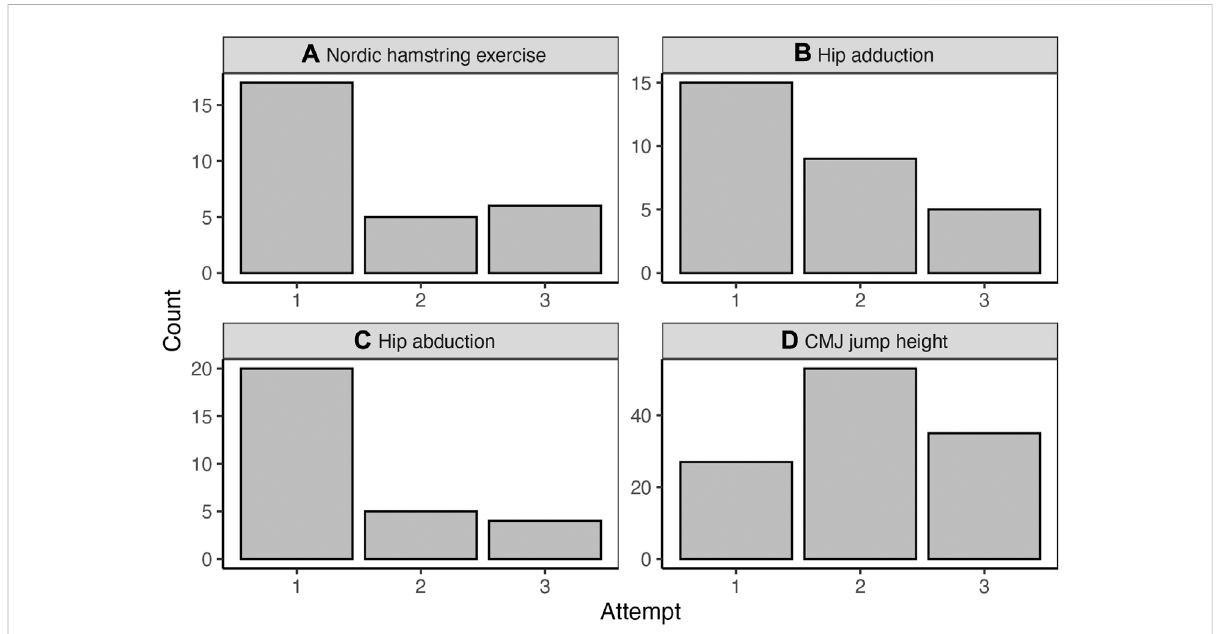
FIGURE 3 Descriptive representation of the best attempt (number of cases on the y -axis) in each test, i.e., Nordic hamstring exercise, hip adduction, hip abduction and countermovement jump performance (A) Nordic hamstring exercise. (B) Hip adduction (C) Hip abduction (D) CMJ jump